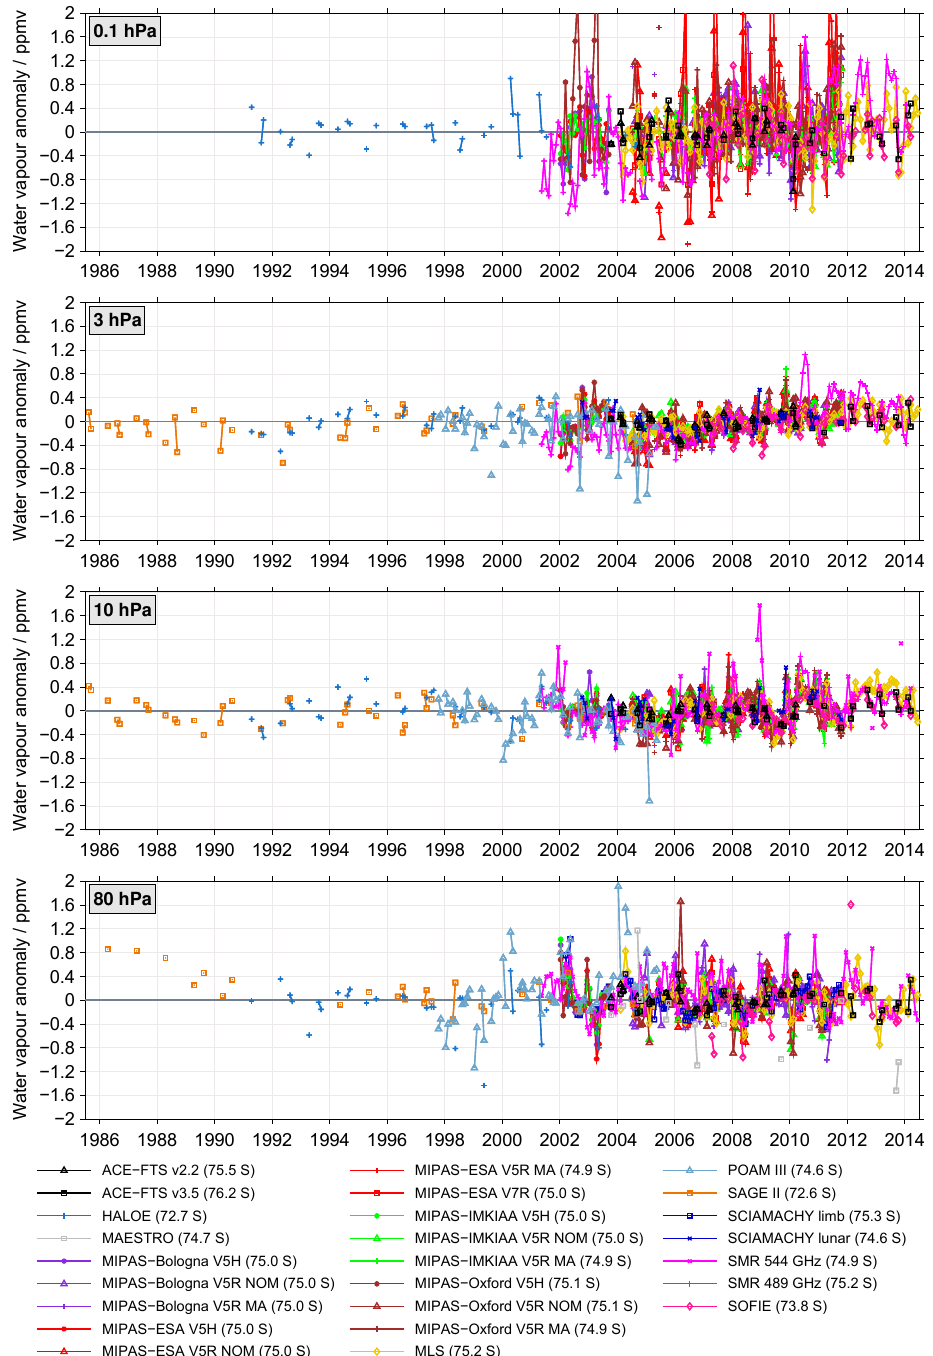
Figure 2. De-seasonalised time series at four different altitudes considering the latitude band 80 ◦ to 70 ◦ S. In the legend the average latitude of the individual time series is indicated, which was calculated in two steps. First, for an individual monthly mean the latitudes of all profiles contributing to it were averaged. Any altitude dependence due to missing or screened data was ignored in this step. Finally, the mean latitudes over the entire time series were averaged. The same anomaly range ( y axis) has been used in all panels so that the differences in the anomaly and the spread can be more easily compared. On the x axis the ticks are given in the middle of the